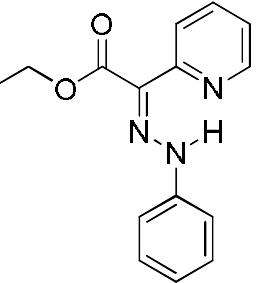
Figure 2. E- configuration of compound 1 , found in solid state and predominantly existing in solution.